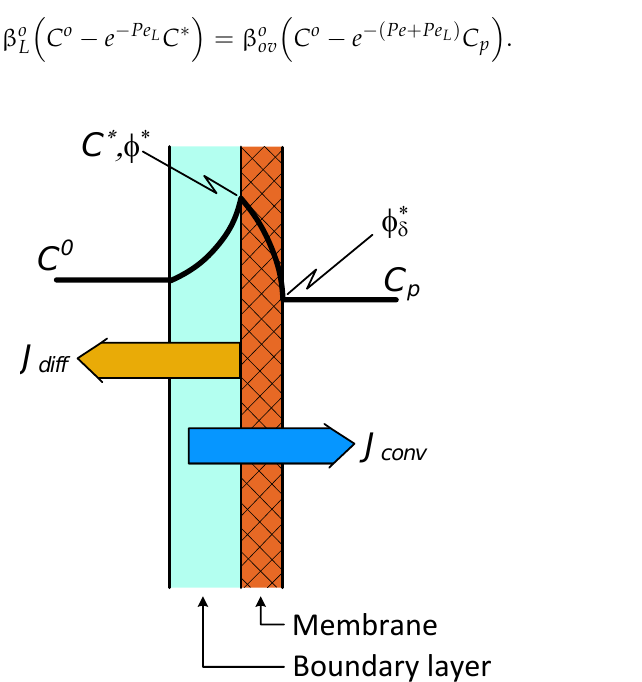
Figure 3. Illustration of the two-layer concentration distribution with convective transport in the membrane layer as well.